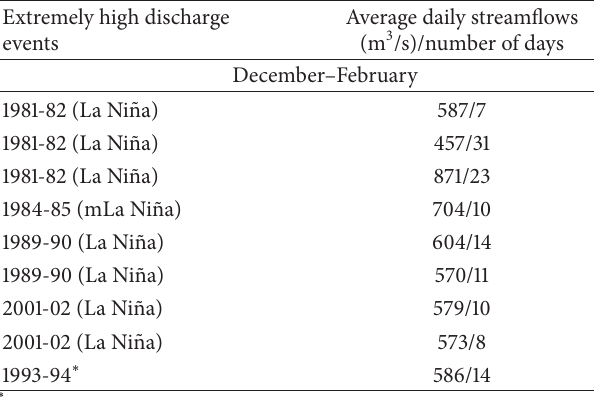
Table 1: Extreme high river discharge events together with the climate conditions during those events. mLa Ni˜na correspond to La Ni˜na Modoki, respectively.